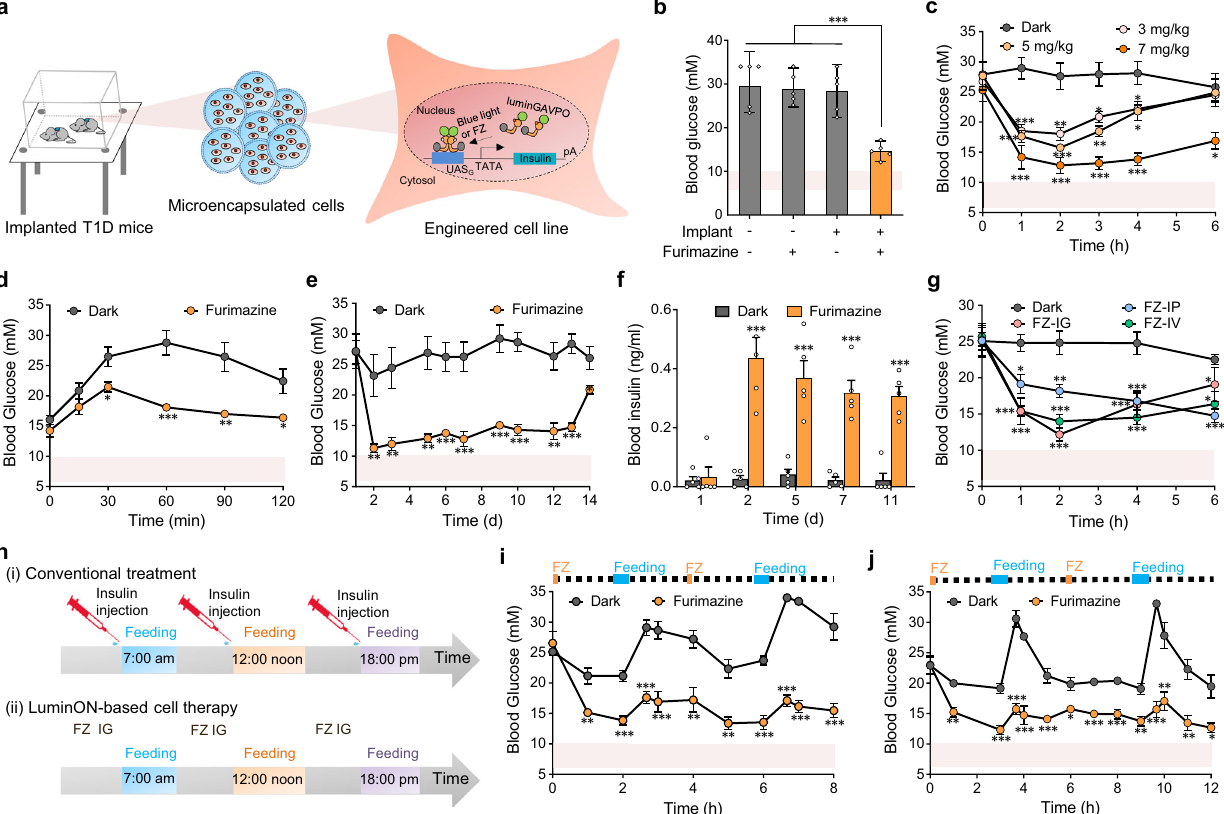
Fig. 4 Pulsatile expression of insulin to enhance blood-glucose homeostasis in type 1 diabetic (T1D) mice. a Schematic representation showing luminGAVPO-mediated insulin expression to enhance blood glucose homeostasis in T1D mice. HEK FUR-Gluc-P2A-mINS cells stably engineered for luminGAVPO-mediated insulin production were microencapsulated into alginate-poly-(L-lysine)-alginate beads and intraperitoneally implanted into T1D mice. b Restoration of blood glucose in T1D mice induced by furimazine. Mice implanted with microencapsulated 4 × 10 6 HEK FUR-Gluc-P2A-mINS cells